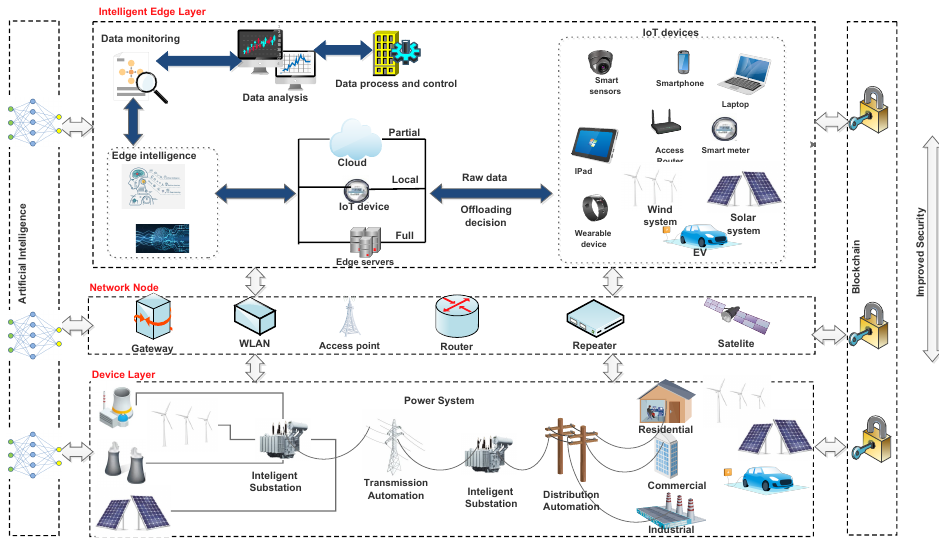
Figure 6. Edge intelligence-based architecture for smart